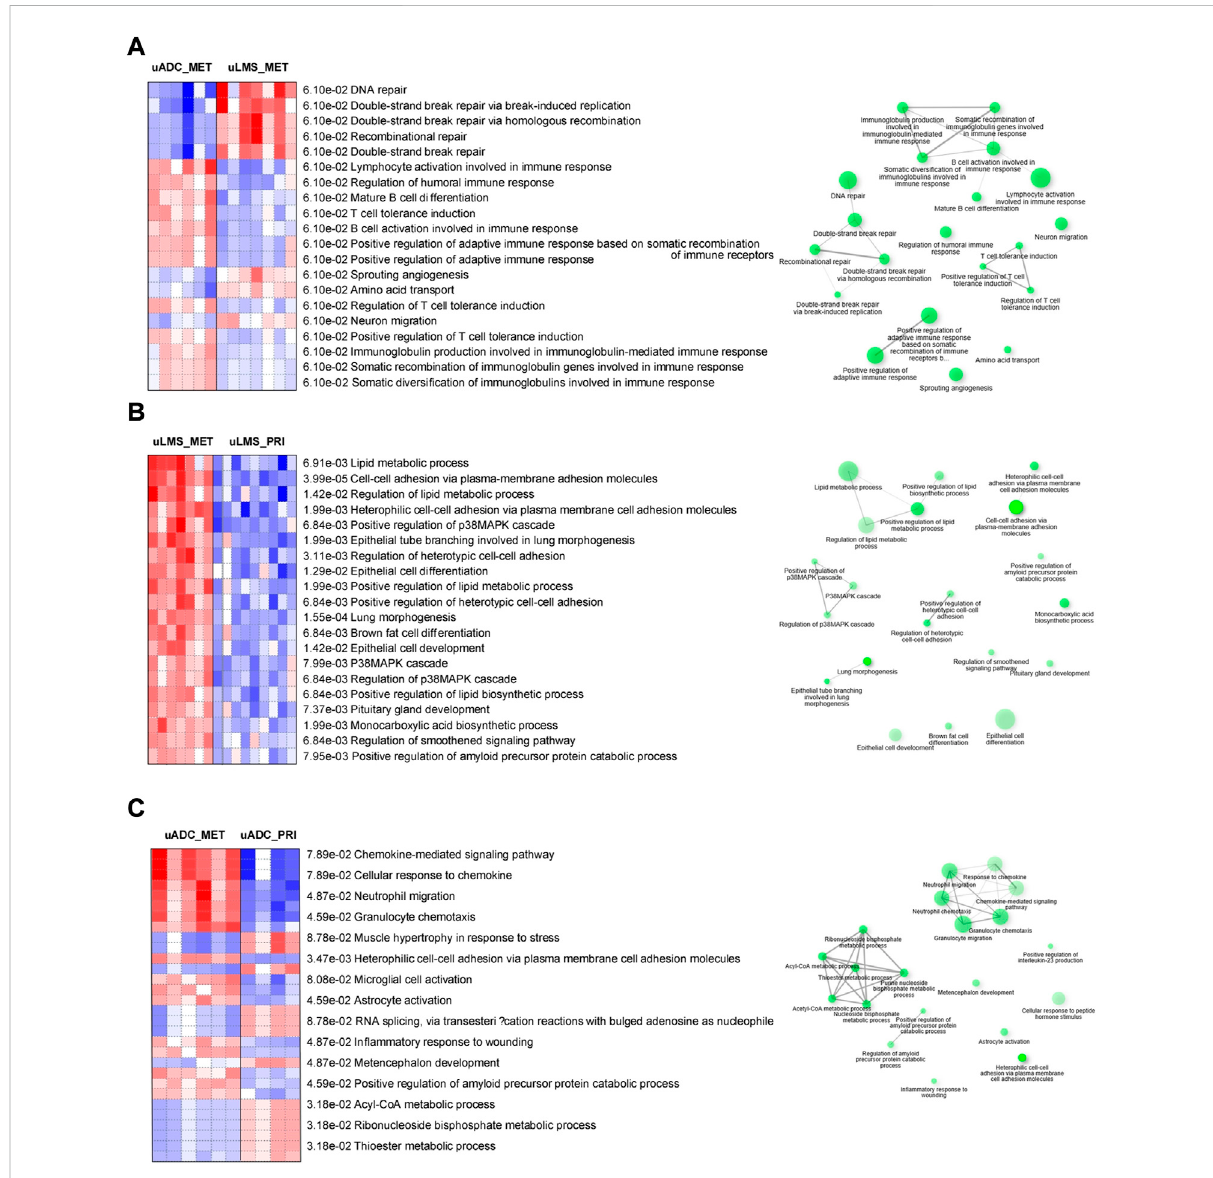
FIGURE 5 Pathwayanalysesoftranscriptionalpro fi lingattheITFofmetastaticandpairedtumors.Comparisonsareindicatedineachpanel (A – C) .Left,red and blue indicate activated and suppressed GO cellular processes, respectively. Right, network of related pathways (nodes). Darker nodes are more signi fi cantly enriched gene sets. Bigger nodes represent larger gene sets. Thicker edges represent more overlapped